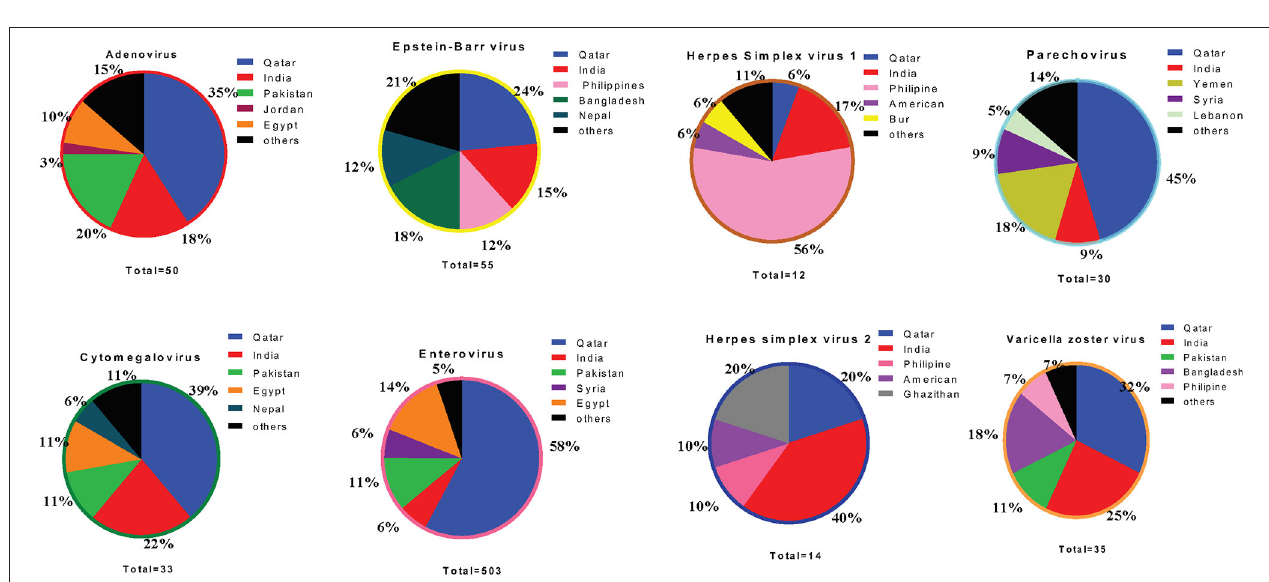
FIGURE 5 | Pie chart representing percentage of top five population among each VM cases during the study period from 2015 to 2018.